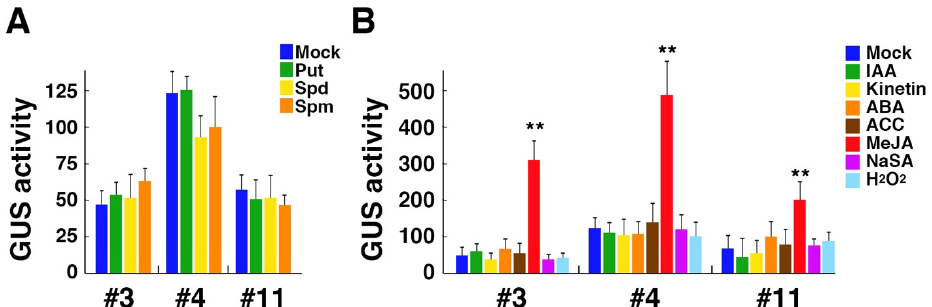
Figure 2. Effect of polyamines and stress-related plant hormones on the GUS activity in three transgenic Arabidopsis lines, #3, #4, and #11, carrying the OsPAO6 promoter-GUS construct. ( A ) The relative GUS activity of 7-day-old seedlings after treatment with 5 mM putrescine (Put), 1 mM spermidine (Spd), or 0.5 mM spermine (Spm) for 24 h. ( B ) The relative GUS activity of 7-day-old seedlings after treatment with 10 μ M IAA, 5 μ M kinetin, 1 μ M ABA, 10 μ M ACC, 2 μ M MeJA, 1 mM NaSA, or 0.3% hydrogen peroxide for 24 h. Data are expressed as mean values ± SD (n = 3). Asterisks indicate the statistical significance analyzed with Student’s t -test (** p < 0.01).